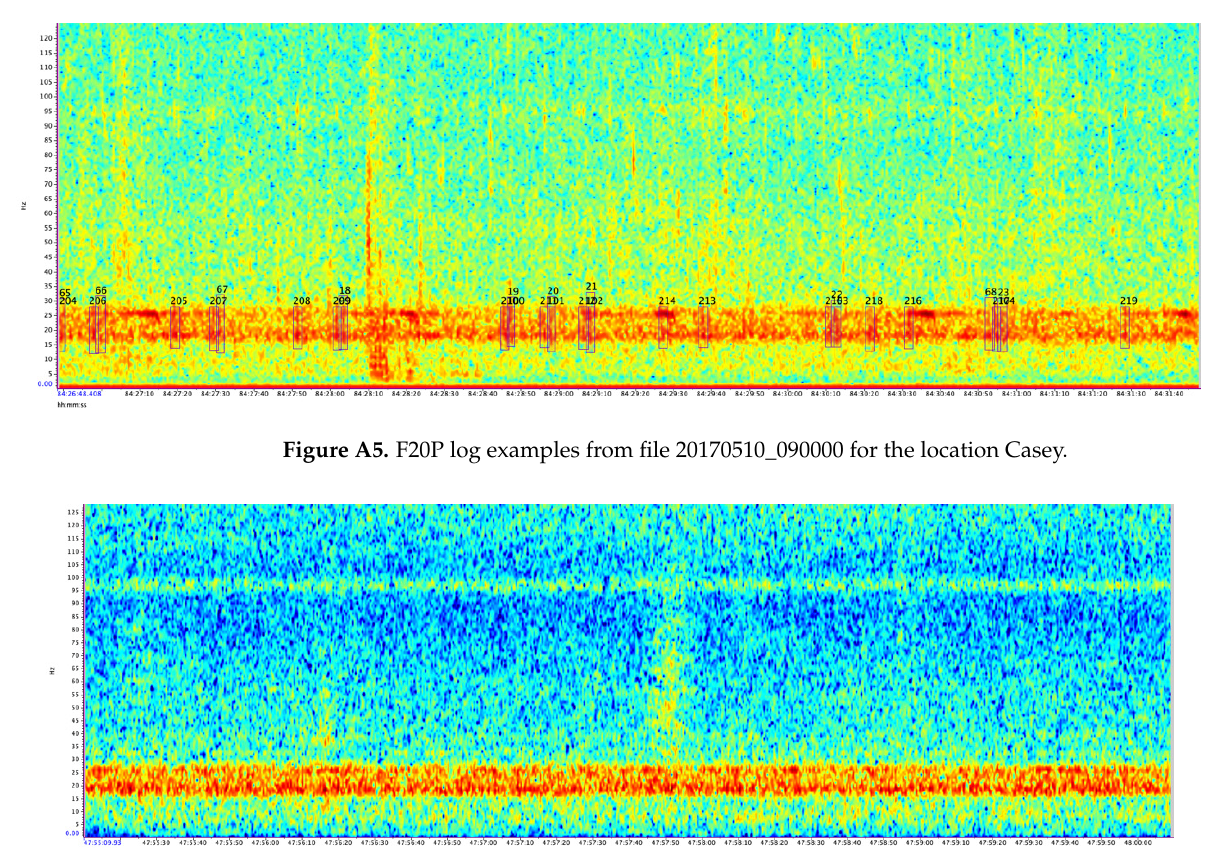
Figure A4. F20P log examples from file Balleny20150322_000000 for the location Balleny Island.